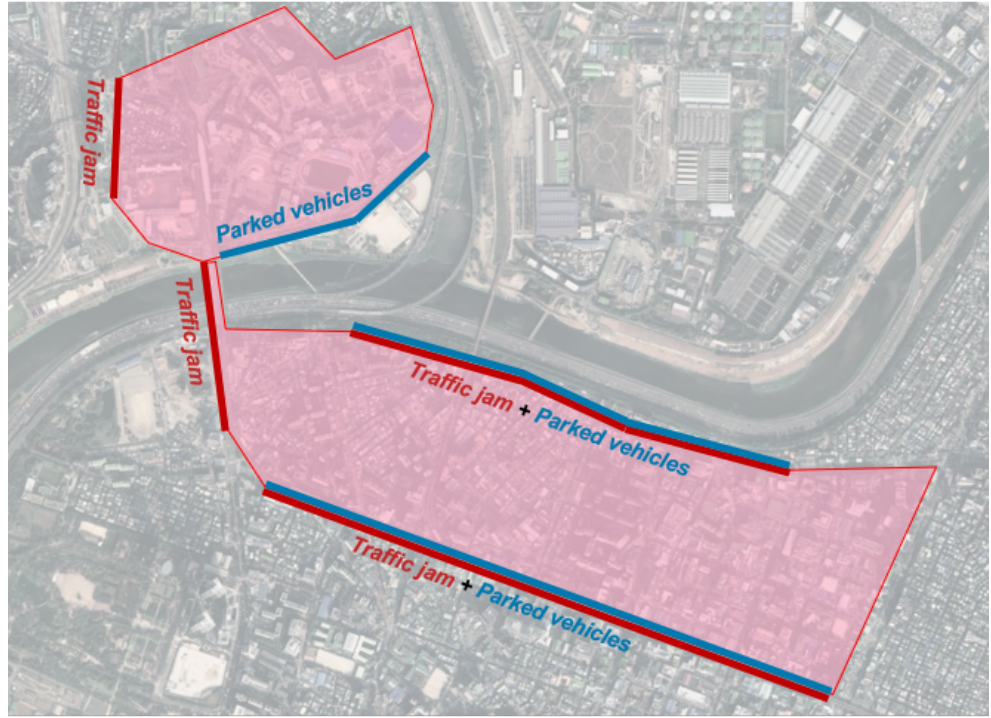
Figure 6. Target route for data